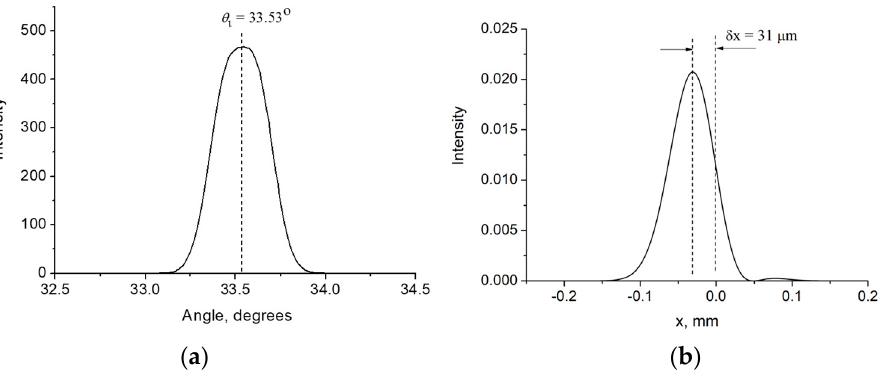
Figure 8. Reflected intensity profiles as function of the reflection angle ( a ) and transverse coordinate ( b ). Incident beam with FWHM = 66.7 μ m; 𝜃 (cid:3036) = 33.53 ° ; z = 0.